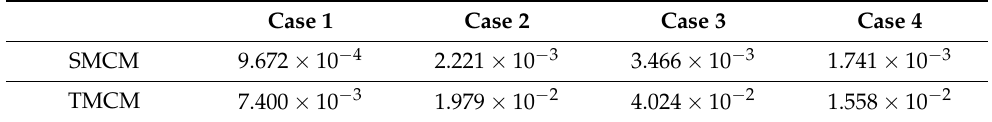
Table 4. The RMSD of SMCM and TMCM in different